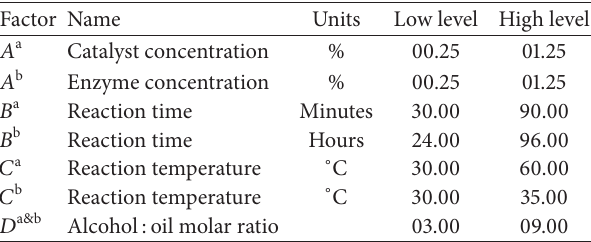
Table 1: CCRD design summary of different levels of reaction variables used for transesterification of palm oil for chemical and enzymatic